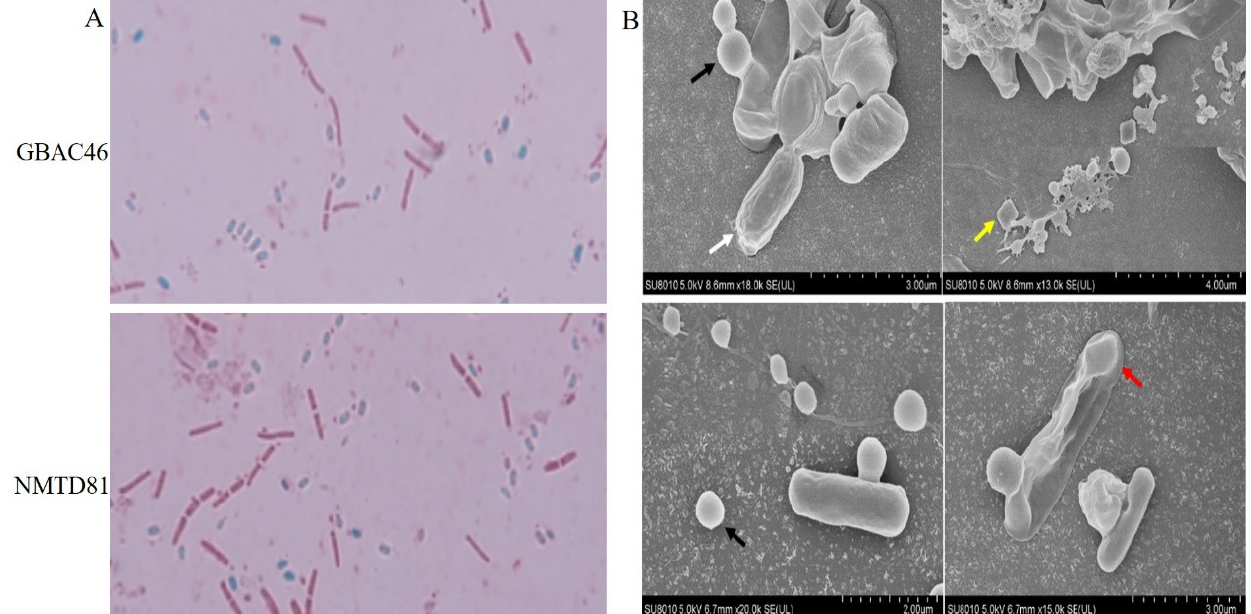
Figure 4. Detection of spore formation in GBAC46 and NMTD81 strains: ( A ) different colors represent different cells: blue—spores, red—living cells under the microscopic study; ( B ) observation of spore and crystal proteins in selected strains under a SEM. White arrow—spores; black arrow—circular crystal proteins; yellow arrow—bipyramidal crystal proteins; red arrow—irregular crystal proteins.